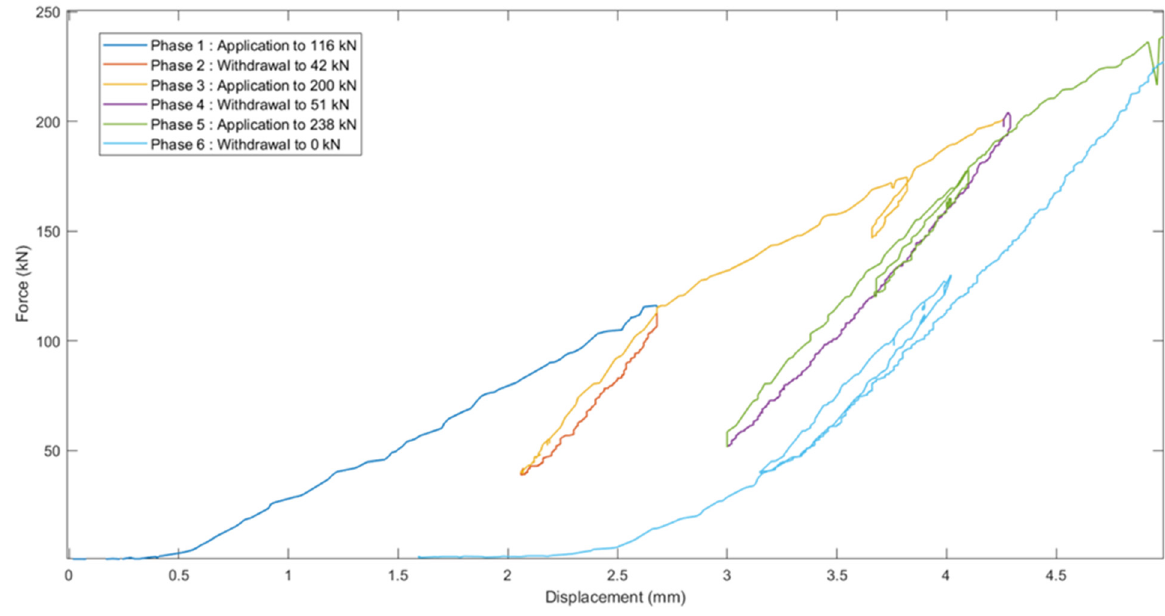
Figure 7. Tension loading, all phases of force application.